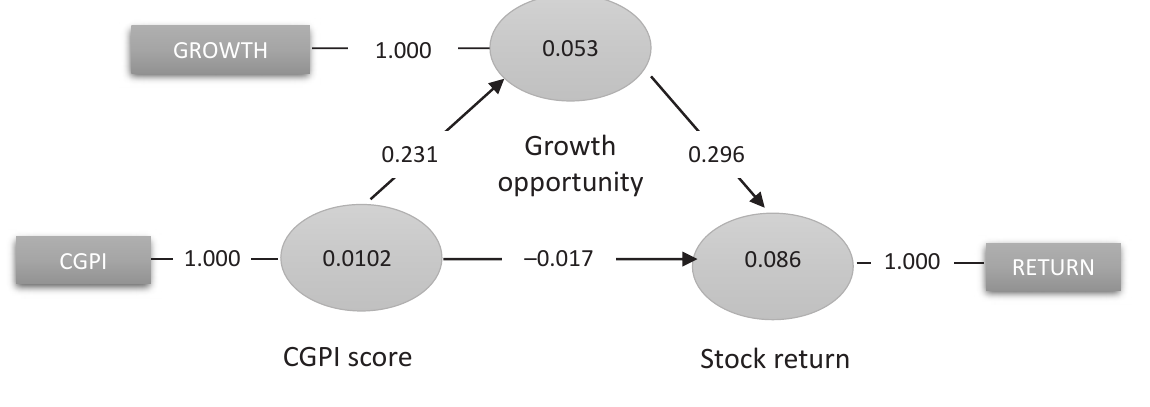
Figure 2. Algorithm of outer output model